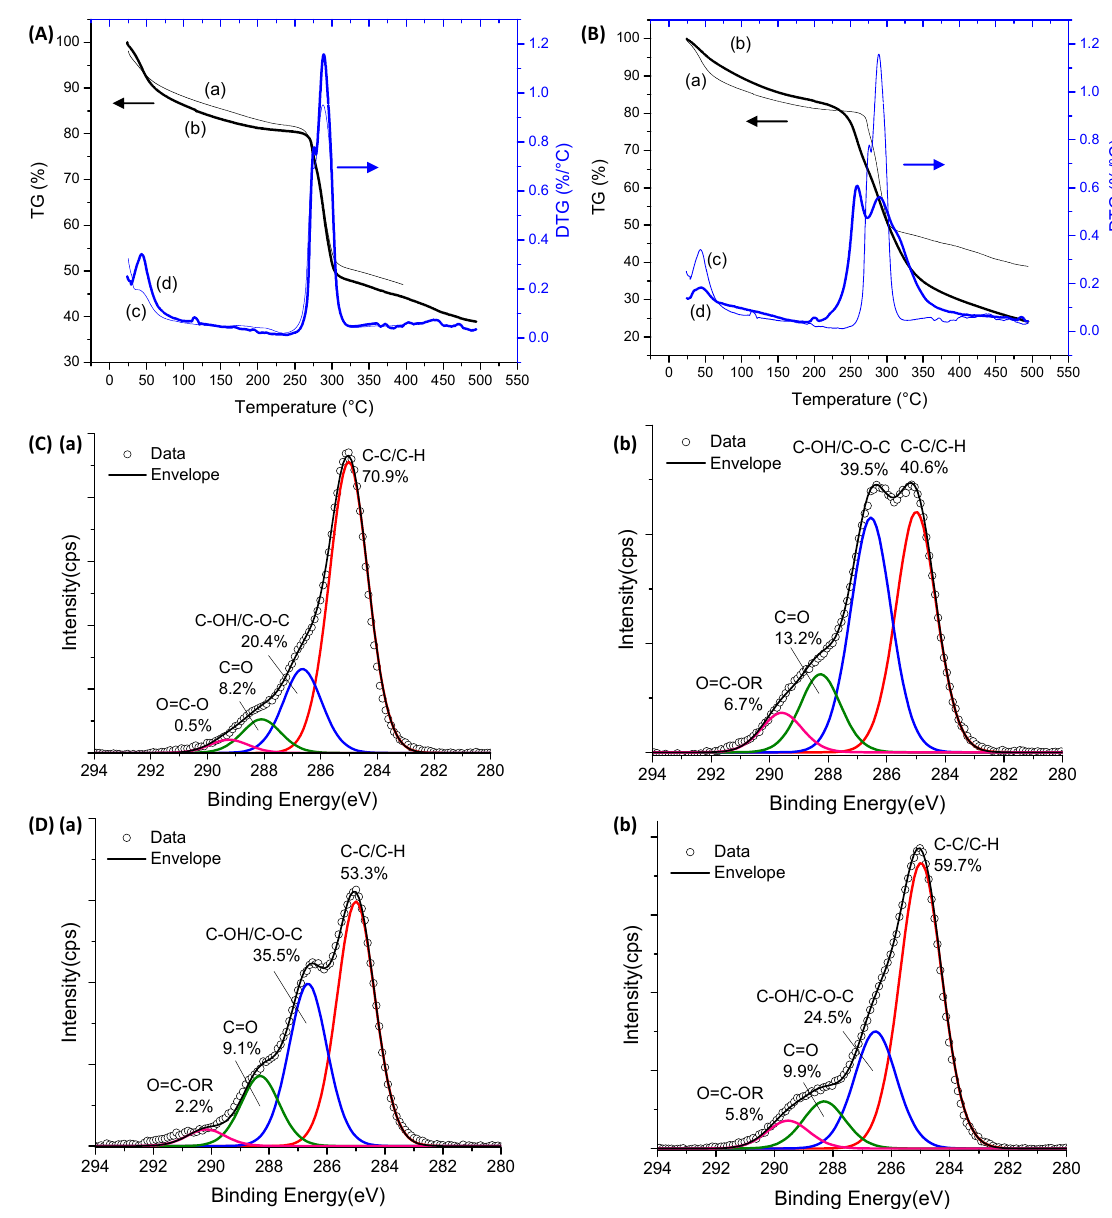
Figure 4. TG ( a , b ) and DTG ( c , d ) analysis of ( A ) CMC-250_CA0 ( ⎯ ) and CMC-700_CA0 ( ⎯ ) and ( B ) CMC-700_CA0 ( ⎯ ) and CMC-700_CA25 ( ⎯ ) hydrogels. XPS analysis of C 1s region for ( C ) CMC-250_CA0 ( a ) and CMC-250_CA25 ( b ) and ( D ) CMC-700_CA0 ( a ) and CMC-700_CA25 ( b ) hydrogels.